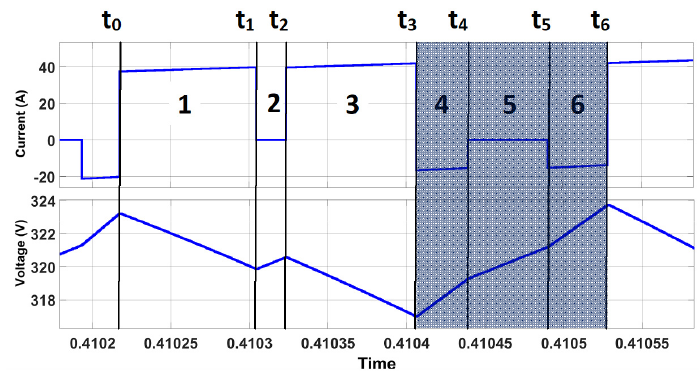
Figure 9. Maximum energy return intervals. Table 3. Distribution of sections and intervals in the critical case.